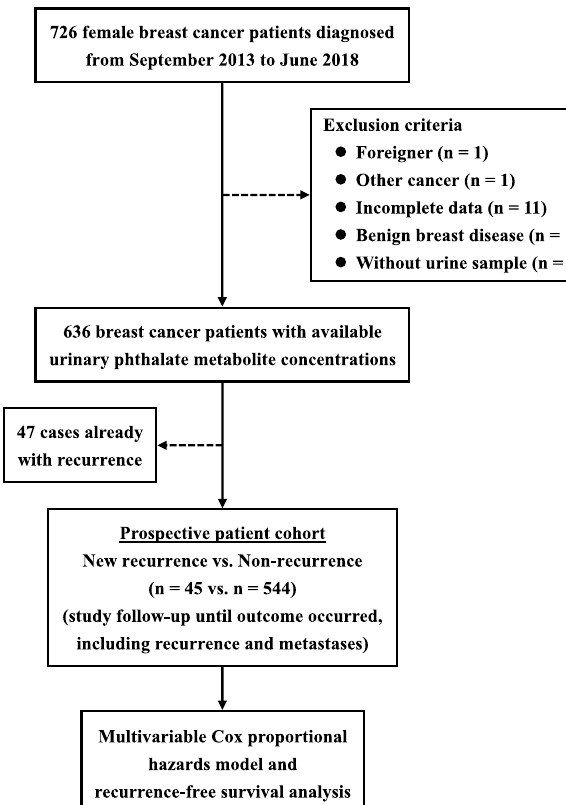
Figure 1. Study design and criteria for recruiting breast cancer